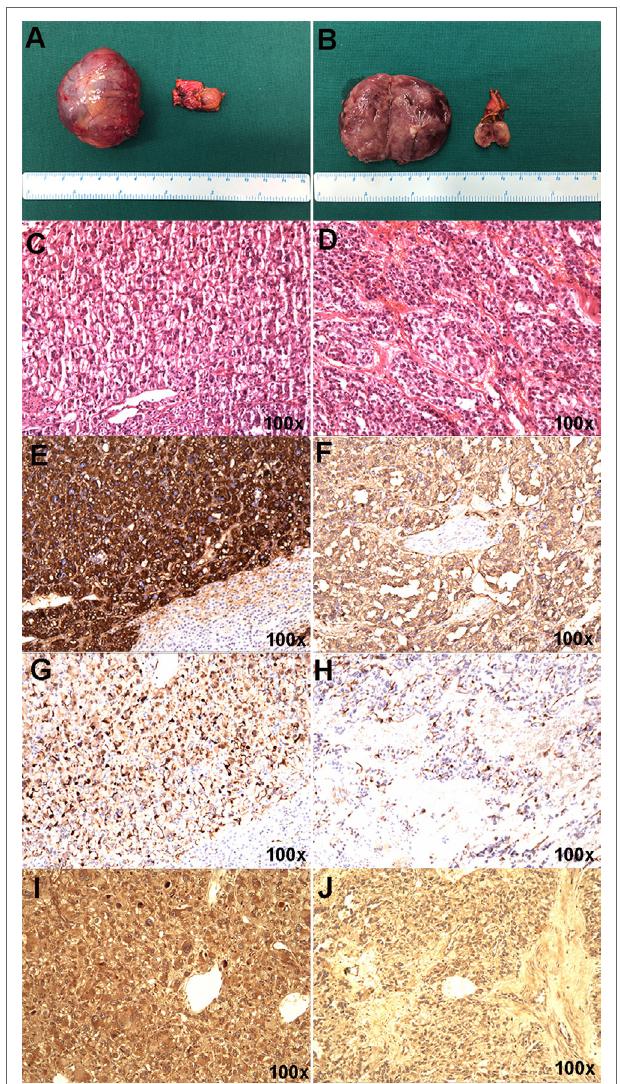
FIgURe 2 | Gross appearance and histopathology of the resected pheochromocytoma and paraganglioma masses. (a,B) The right adrenal gland nodule was about 1.2 cm in diameter, connecting to part of normal adrenal gland tissue. Hematoxylin and eosin staining (C) , chromogranin (e) , S-100 (g) , and HIF-2 α (I) in the right adrenal gland nodule. (a,B) The retroperitoneal mass was about 4.6 cm × 3.3 cm × 4.5 cm in size and the section showed partial necrosis. Hematoxylin and eosin staining (D) , chromogranin (F) , S-100 (H) , and HIF2 α (J) in the retroperitoneal